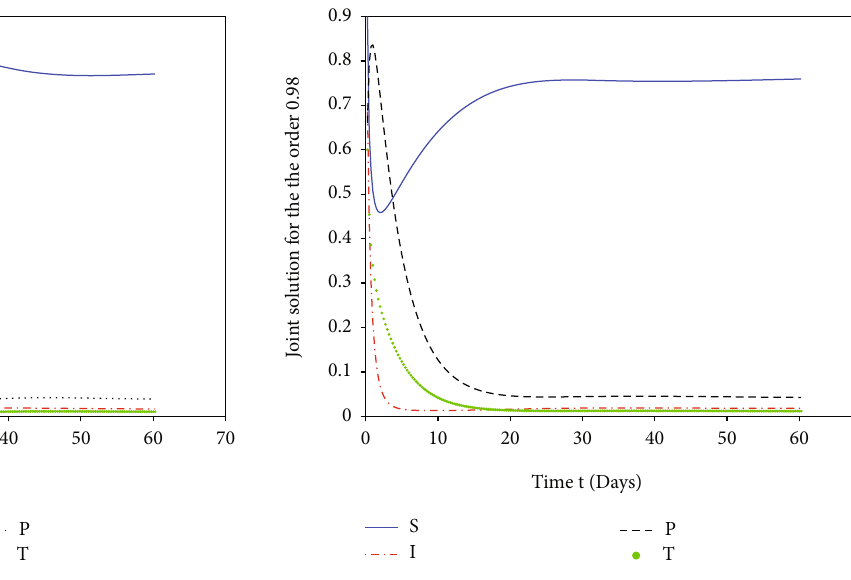
Figure 1: The joint solution for ϱ = 1 . Figure 2: The joint solution for ϱ = 0 : 98 .